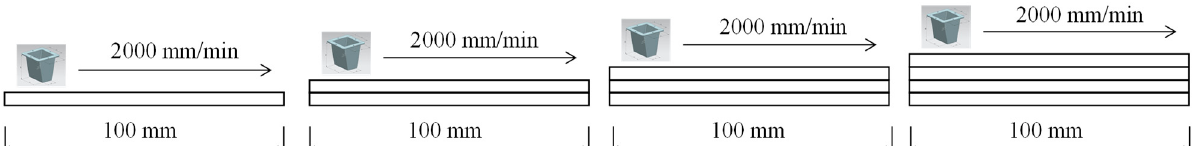
Figure 10. Designed printing test schedule for straight line.